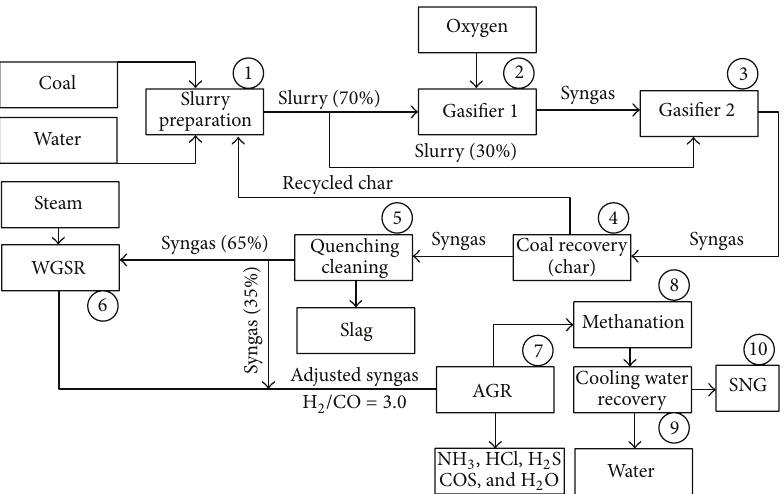
Figure 1: Process stages of SNG production via coal gasification using slurry feeding technology.